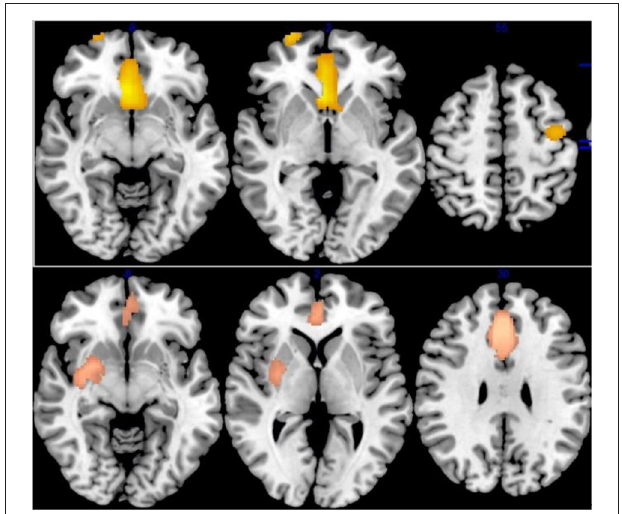
FIGURE 2 | Results of Voxel-Based Morphometry (VBM) for IGD and ADHD. Results of VBM meta-analysis for, from top to bottom, patients with Internet gaming disorder (IGD) relative to controls, patients with attention-deficit/hyperactivity disorder (ADHD) relative to controls.